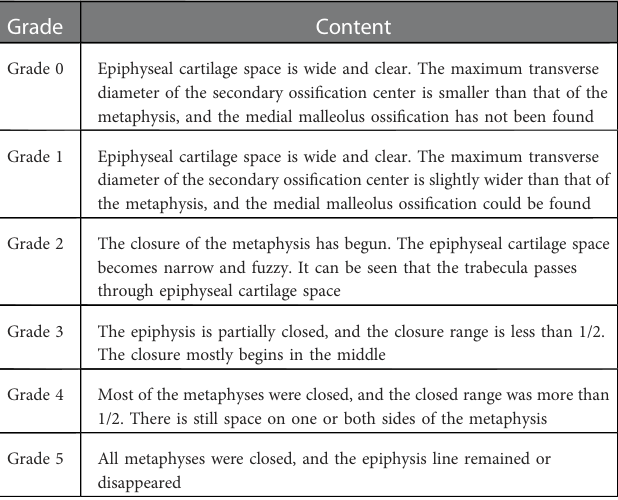
TABLE 1 Grades of tibial epiphysis